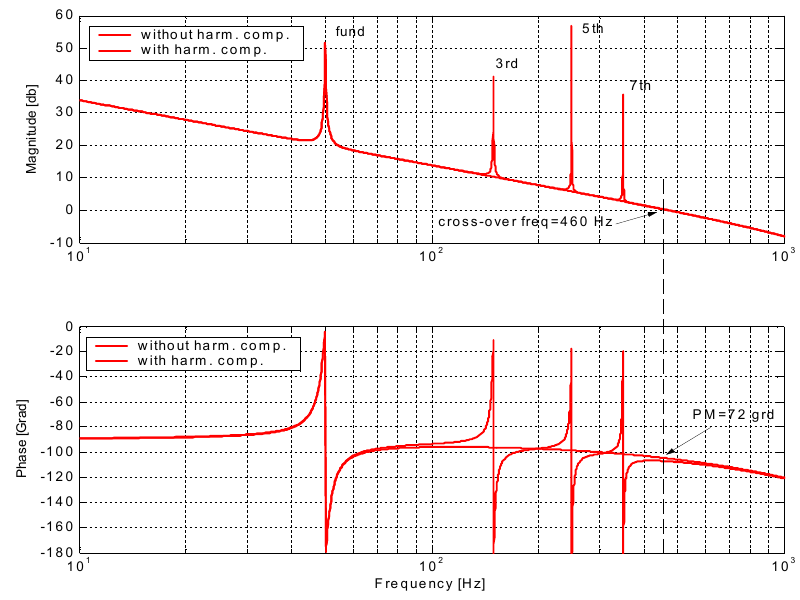
Figure 8. Bode diagram of the open-loop gain using the PR current control system with and without harmonic compensators.